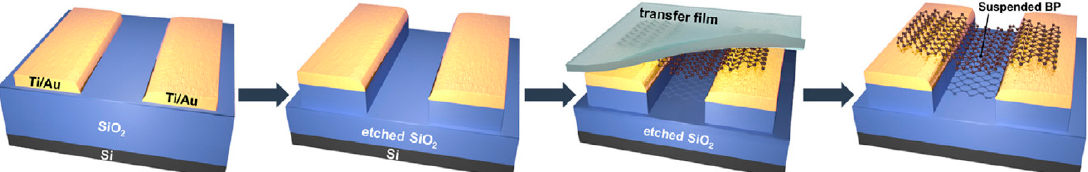
Figure 8. Schematic of fabrication of the suspended structure via dry transfer. Suspended BP flakes were fabricated on two high posts formed by the etched SiO 2 layer. Reproduced with permission from Ref. [123]. Copyright Elsevier, 2017.